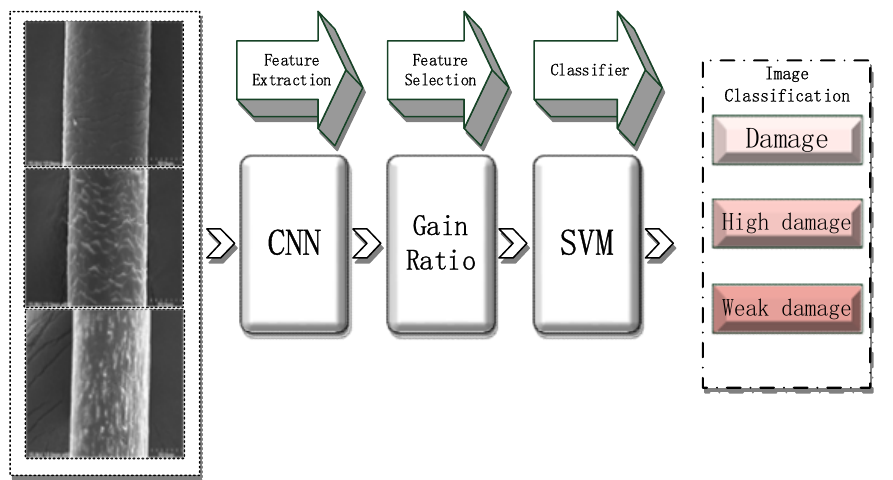
Figure 3. Flowchart of hair damage diagnosis.